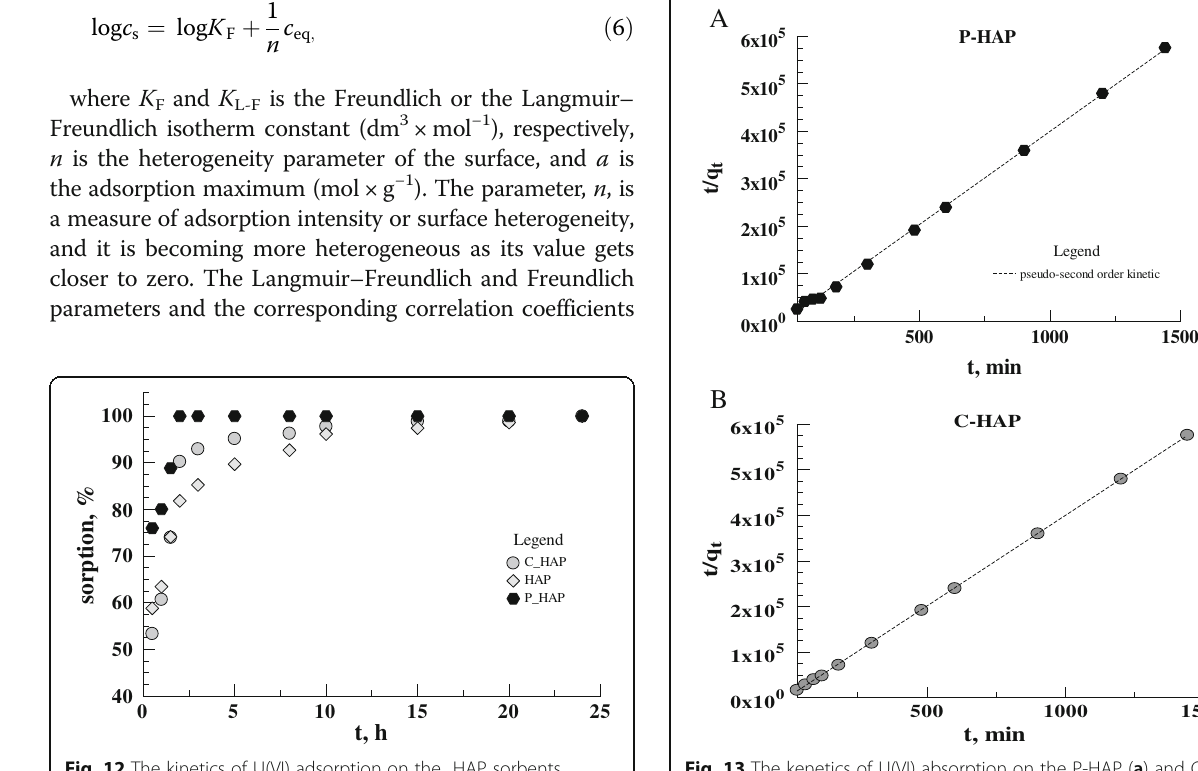
Fig. 12 The kinetics of U(VI) adsorption on the HAP sorbents (293 K; c in U(VI) = 0.5 mmol × dm − 3 ; pH = 6)